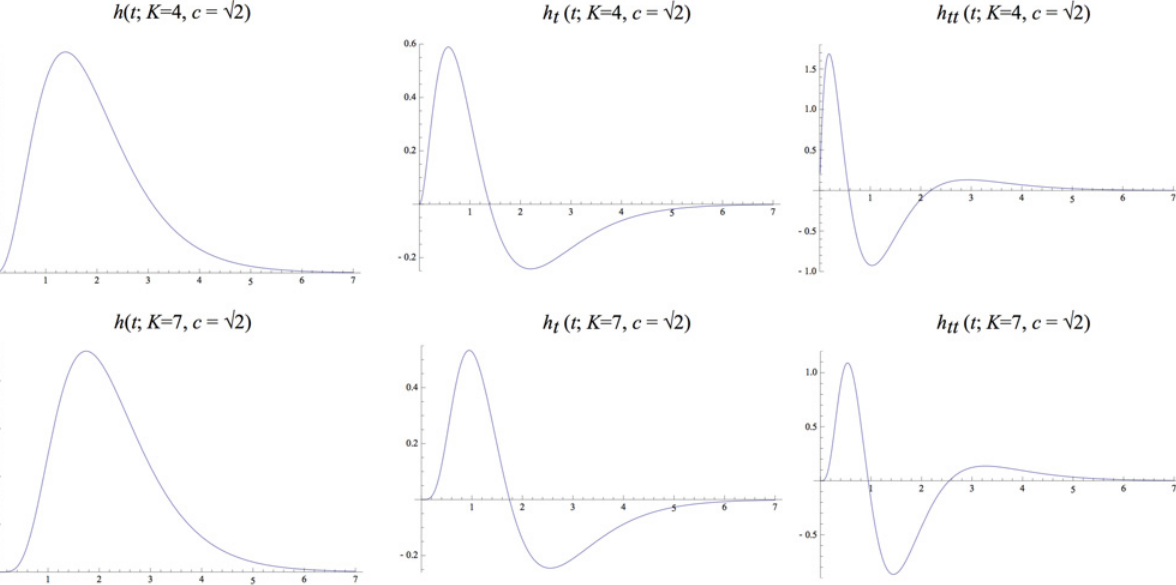
ð t ; m Þ ¼ (cid:3) K ð t ; m Þ with temporal variance τ = 1 corresponding to the composition of K = 4 or K = 7 truncated h Fig 5. Equivalent kernels h composed exp k k ¼ 1 exponential kernels with different time constants defined from a self-similar distribution of the temporal scale levels according to Equations (38), (39) and (40) and corresponding to a uniform distribution in terms of effective temporal scale τ eff = log τ for c ¼ order derivatives.